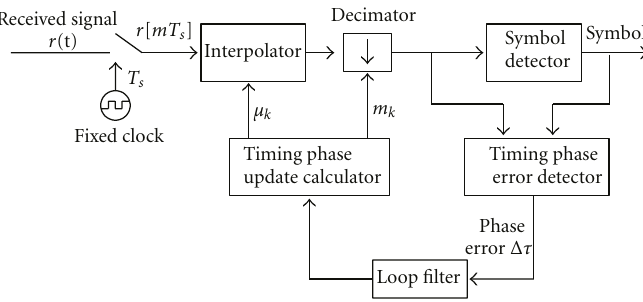
Figure 1: Interpolated timing recovery scheme.